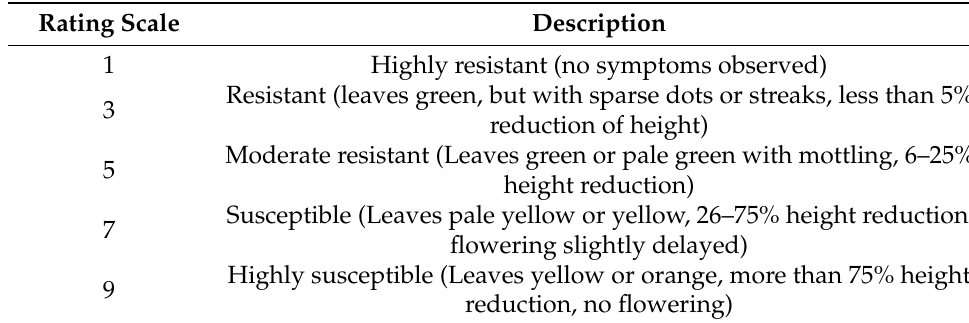
Table 3. RYMV disease severity rating scale and description